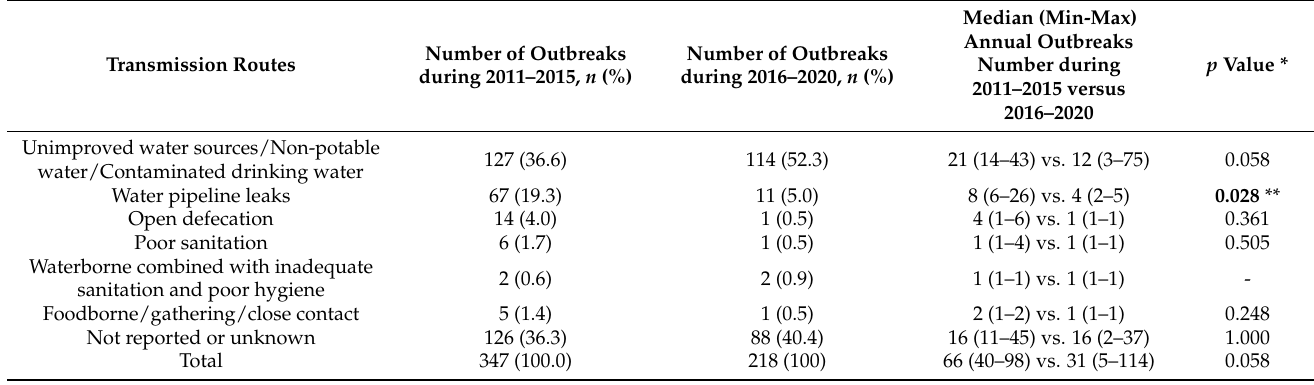
Table 2. Number of cholera outbreaks during the period 2011–2015 compared with